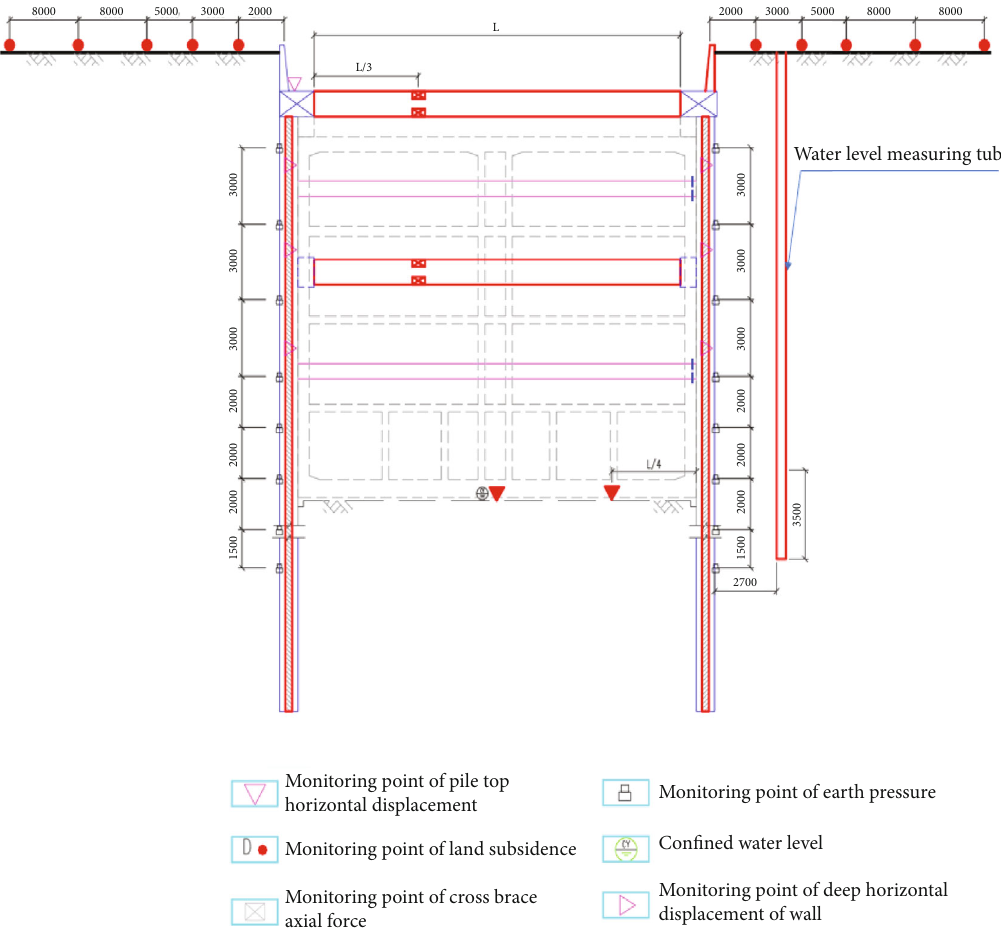
Figure 10: Monitoring section of a typical foundation pit.